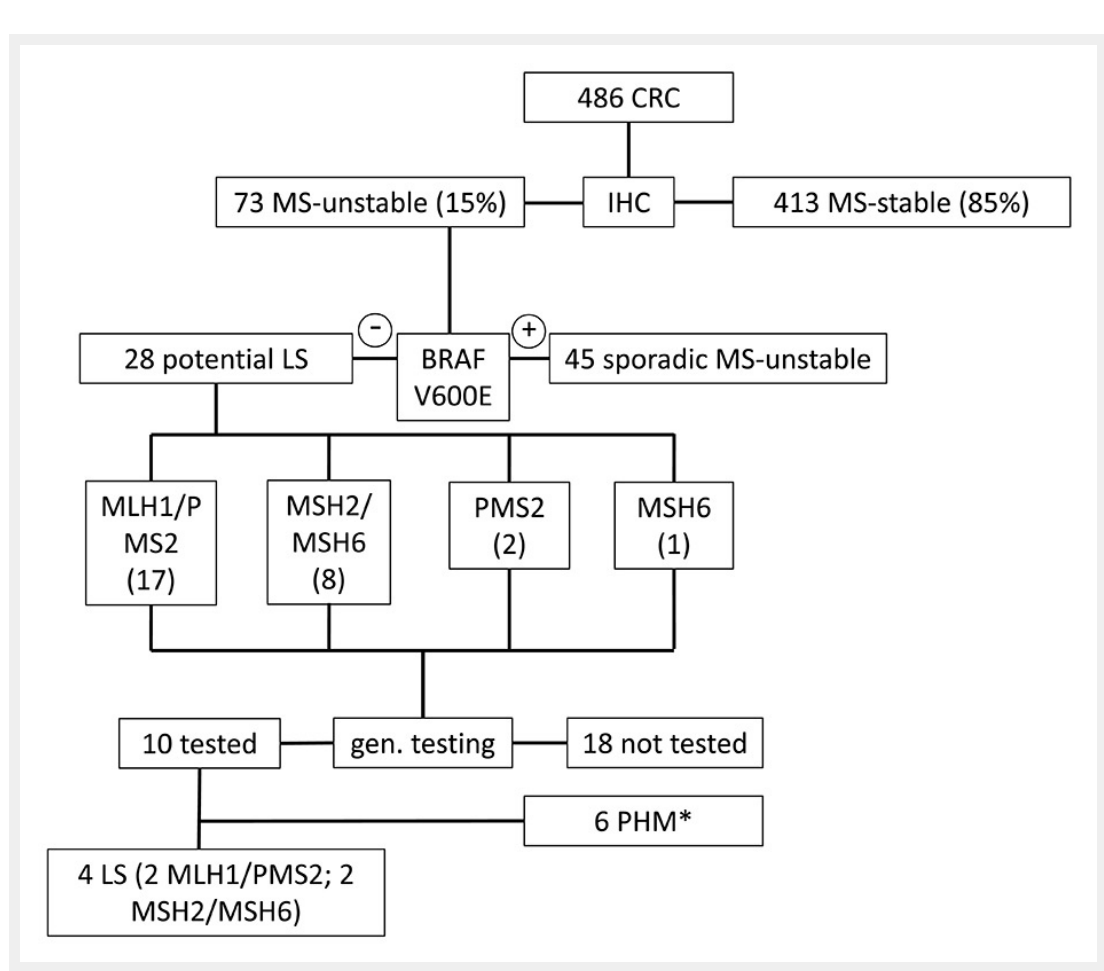
Figure 1 Study schema for universal screening for LS of all newly diagnosed CRC patients. Of all patients (n = 486), loss of MMR protein expression was found in 73 (15.0%) tumours. 28 (6.0%) were classified as potential LS carriers. Of the genetically tested potential LS carriers (10 out of 28 patients), 40% were first diagnosed with LS. * Promoter hypermethylation CRC = colorectal cancer; IHC = immunohistochemistry; LS = Lynch syndrome; MMR = DNA mismatch repair; MS =